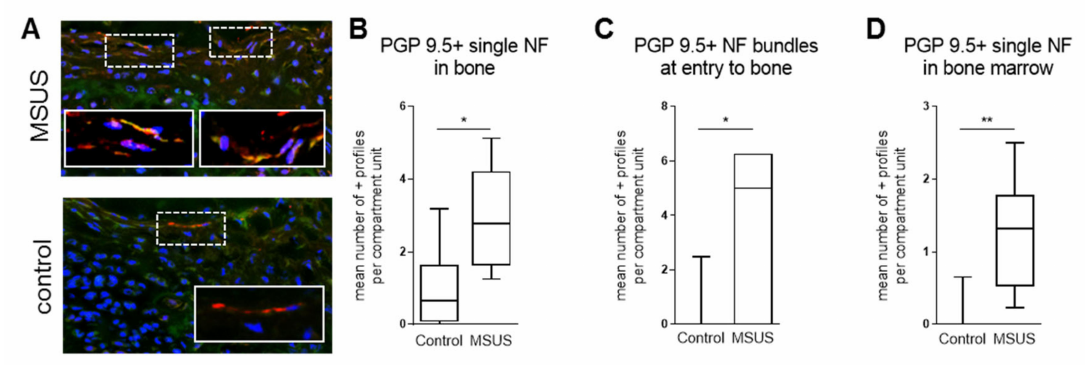
Figure 3. Increased bone innervation in MSUS mice. Representative images of the third tail bone from control and MSUS mice labeled with protein gene product 9.5 (PGP 9.5) pan-neuronal marker for immunofluorescence histomorphometry of nerve fibers (nerve fibers (NF)-red) in bone. Nuclei are counterstained with 4 (cid:48) ,6-diamidino-2-phenylindole (DAPI) (blue), mast cells with fluorescein isothiocyanate (FITC)-avidin (green) ( A ). Shown are the increased mean numbers of immune-positive profiles per compartment unit of single NF in bone ( B ), NF bundles at entry to bone ( C ) and single NF in bone marrow ( D ). Data ( n = 8 Control, n = 6–7 MSUS) are expressed as Min to Max of number of positive profiles per compartment unit. Significance level: ** p < 0.01 and * p < 0.05 between indicated groups.